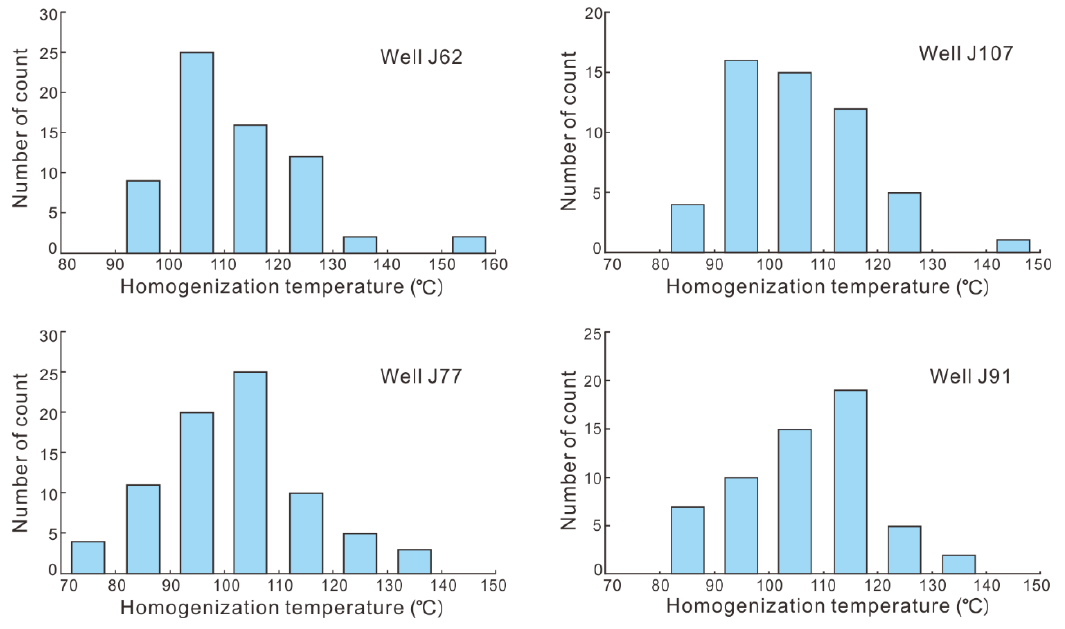
Figure 7. Histograms of homogenization temperatures of aqueous inclusions coexisting with hydrocarbon inclusions from the sandstones in the Lower Shihezi Fm. Table 2. Characteristics of the hydrocarbon inclusions from the Lower Shihezi Fm. in the Hangjinqi area, north Ordos Basin. GI: gas inclusion; OI: oil inclusion; AI: aqueous